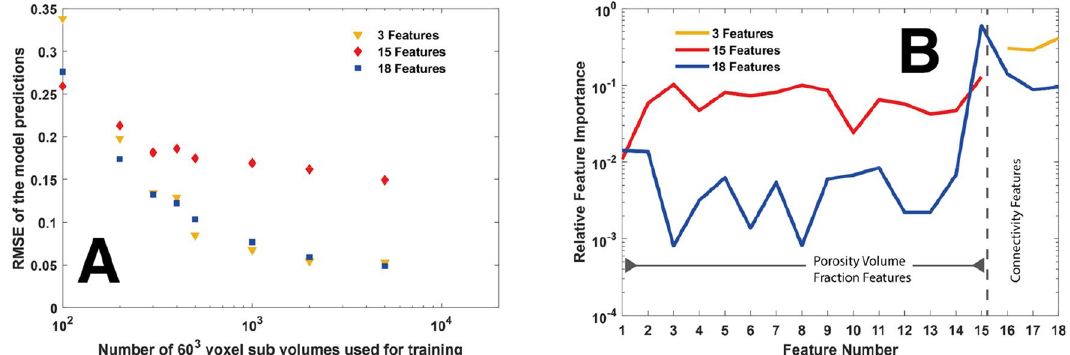
Figure 3. ( A ) The RMSE of the of the different feature sets plotted against the number of training sub-volumes used to train the model. ( B ) The relative feature importance for regression models of training set 1 using 3 features (yellow), 15 feature (red), and 18 features (blue). Data in this figure was computed using SciKitLearn 41 and rendered using MATLAB 48 .